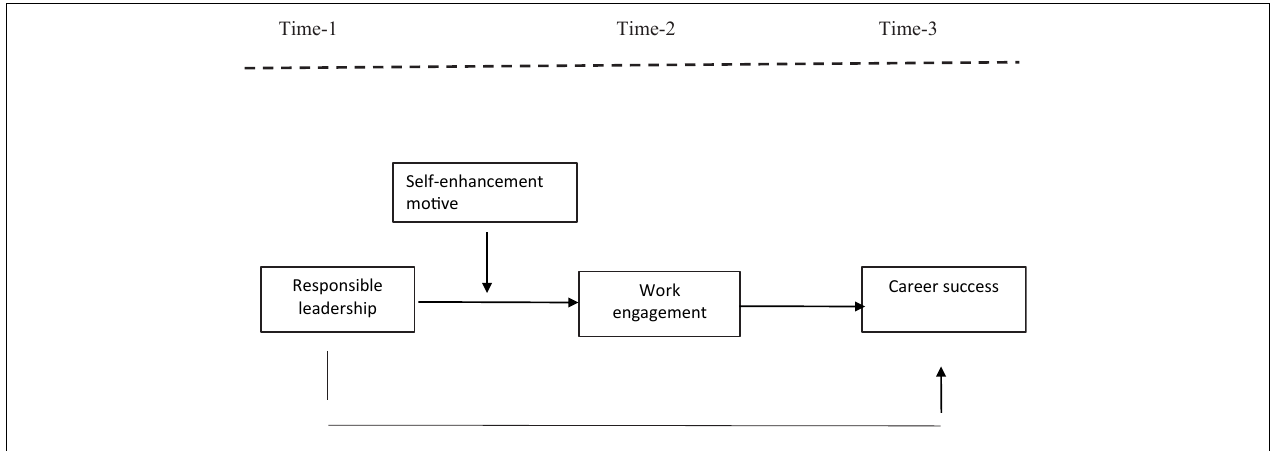
FIGURE 1 | Research